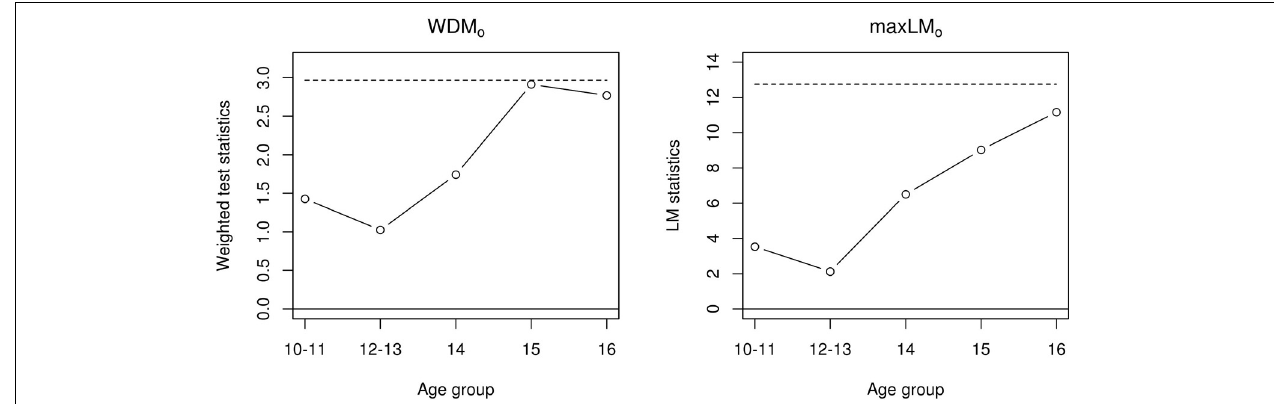
FIGURE 1 | Fluctuation processes for the WDM o statistic (left panel) and the max LM o statistic (right panel).